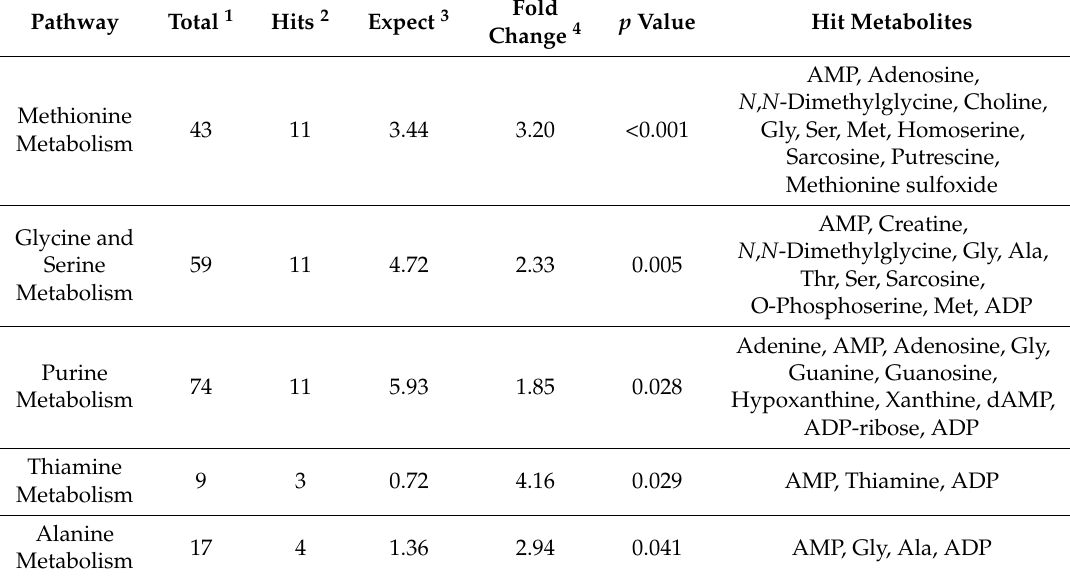
Table 1. Metabolic pathways significantly changed in AD compared to control as assessed by